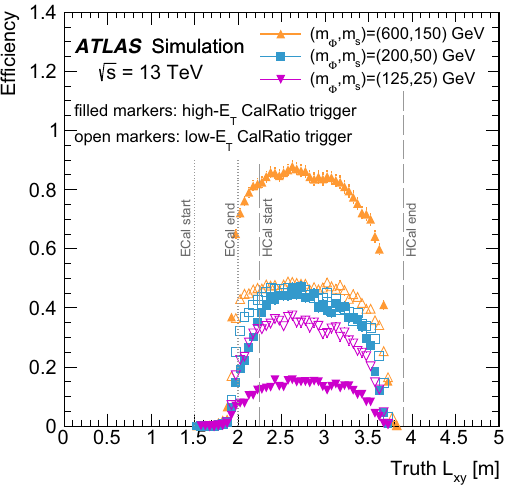
Fig. 1 Trigger efficiency of simulated signal events as a function of the LLP p T (left) and the p T distribution of LLPs (right) for a selection of signal samples